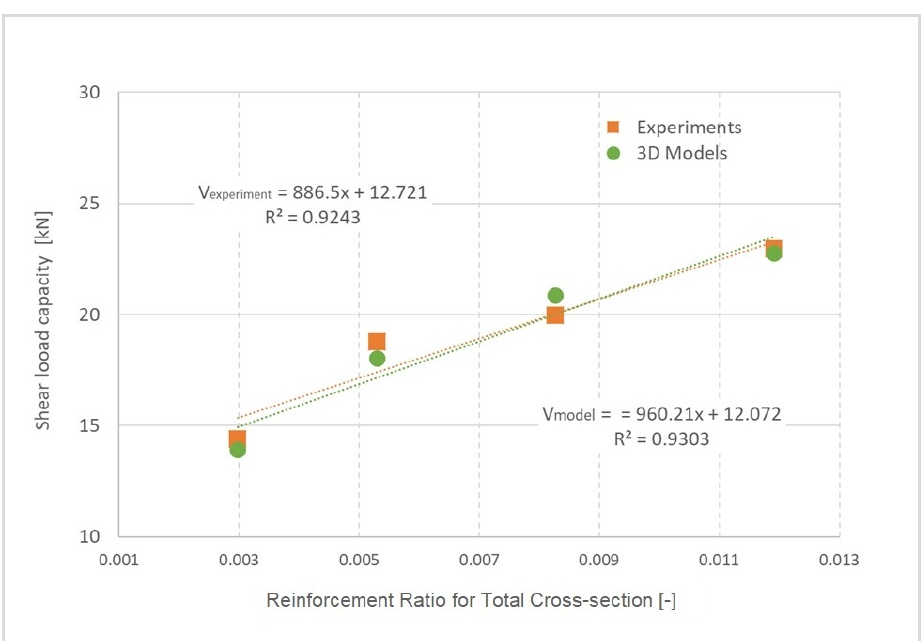
Figure 16. Shear load capacity of reinforced concrete beam without transverse